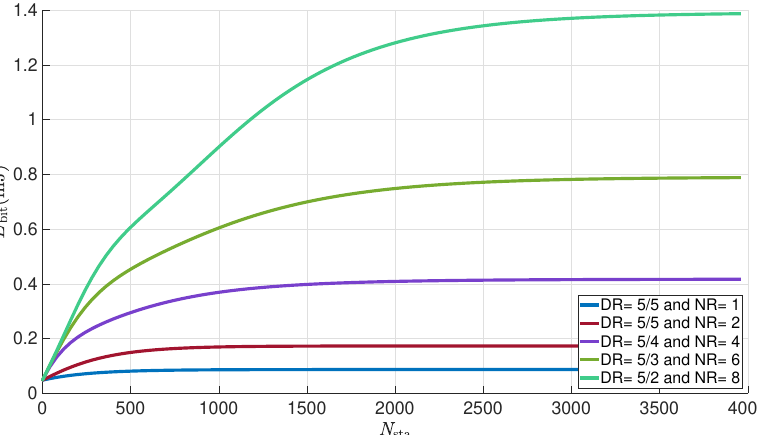
Figure 19. Average energy consumed per useful bit by a LoRa sensor for various numbers of attempts vs. number of nodes in the network (FPayload = 50 bytes; P tx = 14 dBm; d = 1 km; dc =